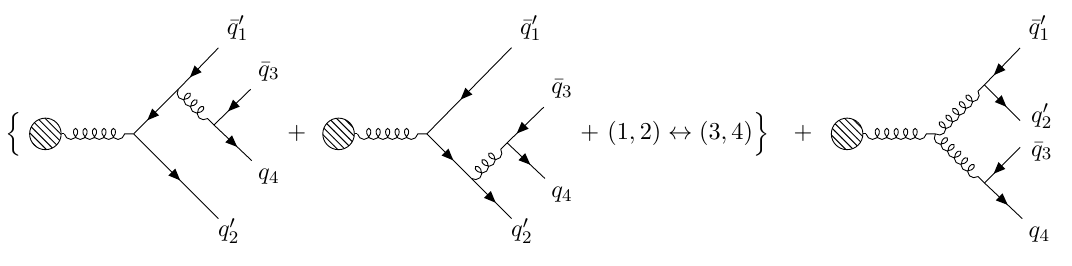
(cid:22) q 3 q 4 . In the case of identical q 0 1 2